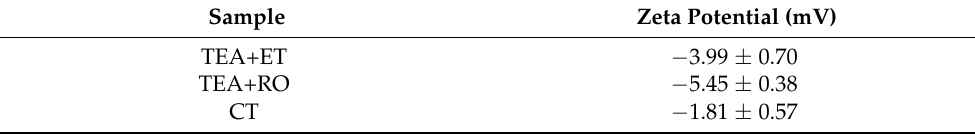
Table 4. Zeta potential of three experimental groups (Detection immediately after